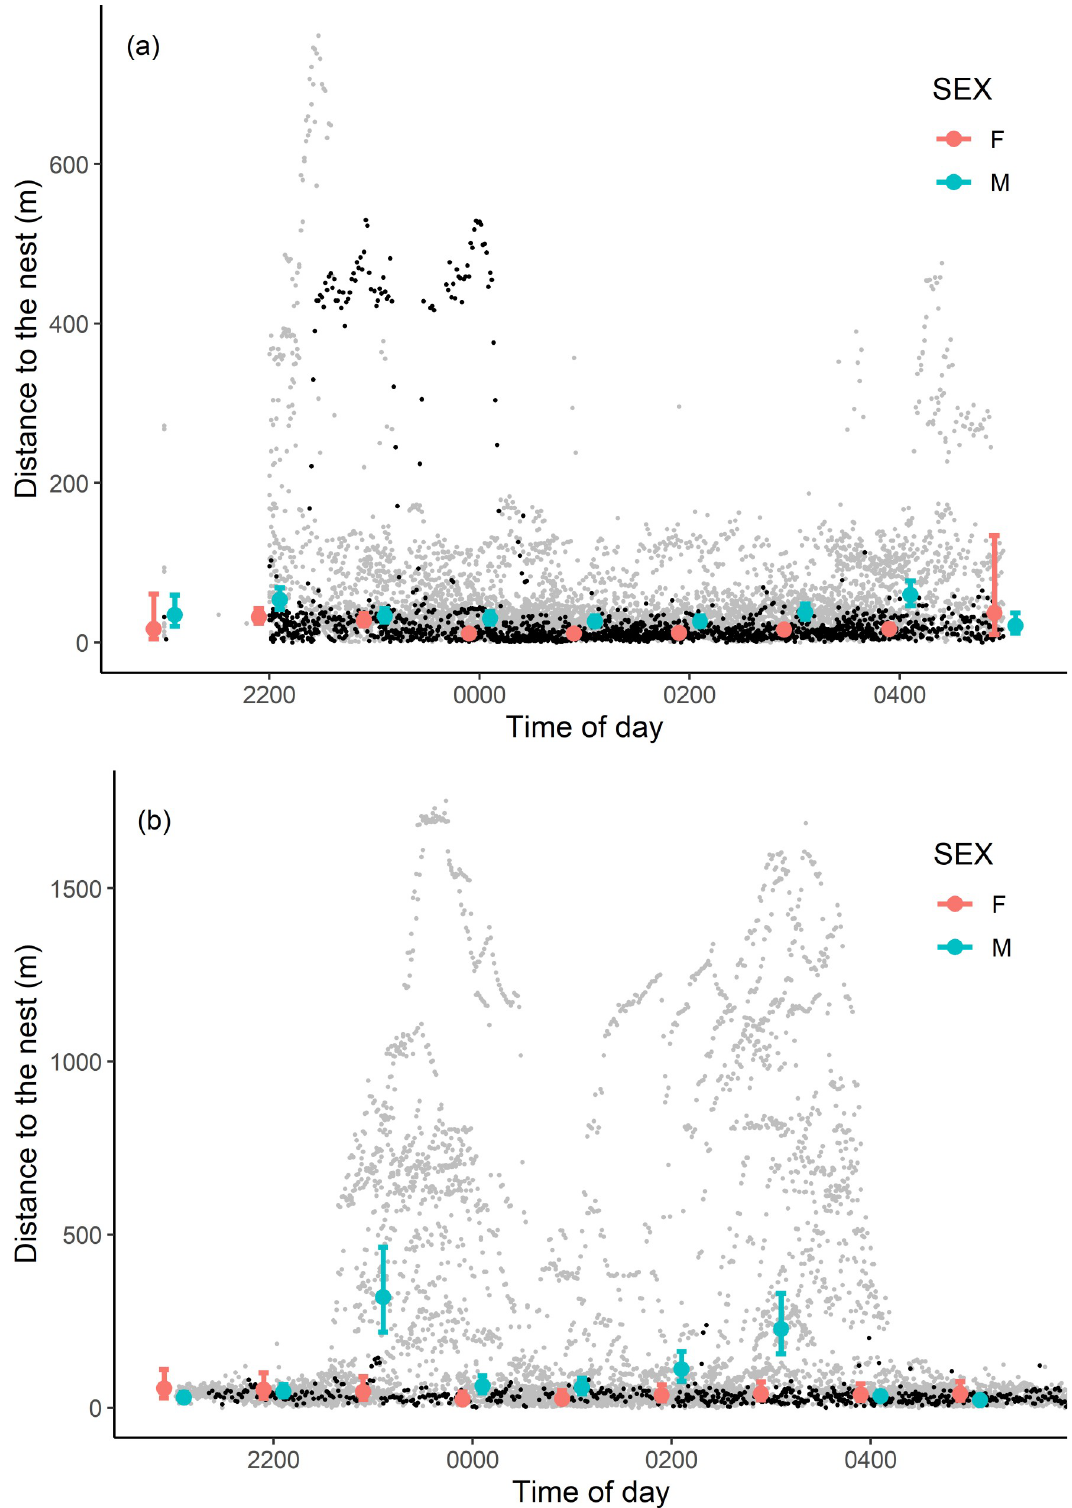
Fig 2. Distance to the nest in relation to the local time of day (CEST) shown separately for little owls tracked in the Czech Republic (a) and Denmark (b) . Model estimates (large dots) and 95% confidence intervals (bars) are shown separately for